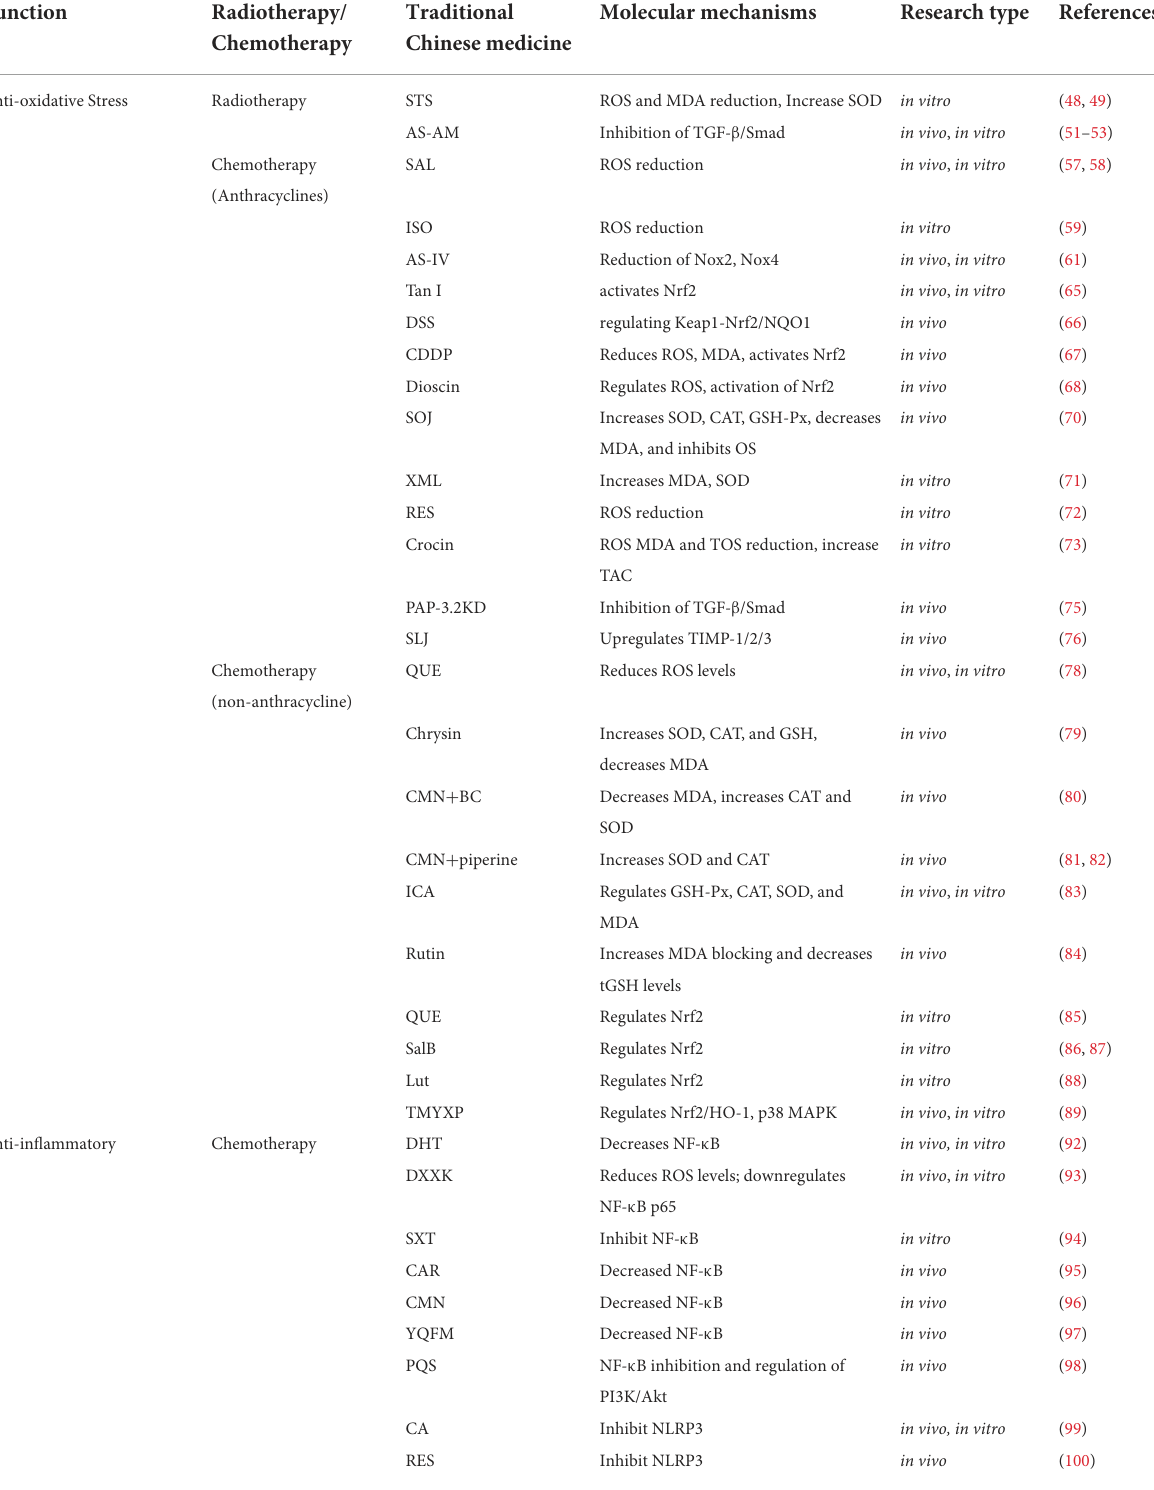
TABLE 1 Protective effects and mechanisms of traditional Chinese medicine against chemoradiotherapy-related